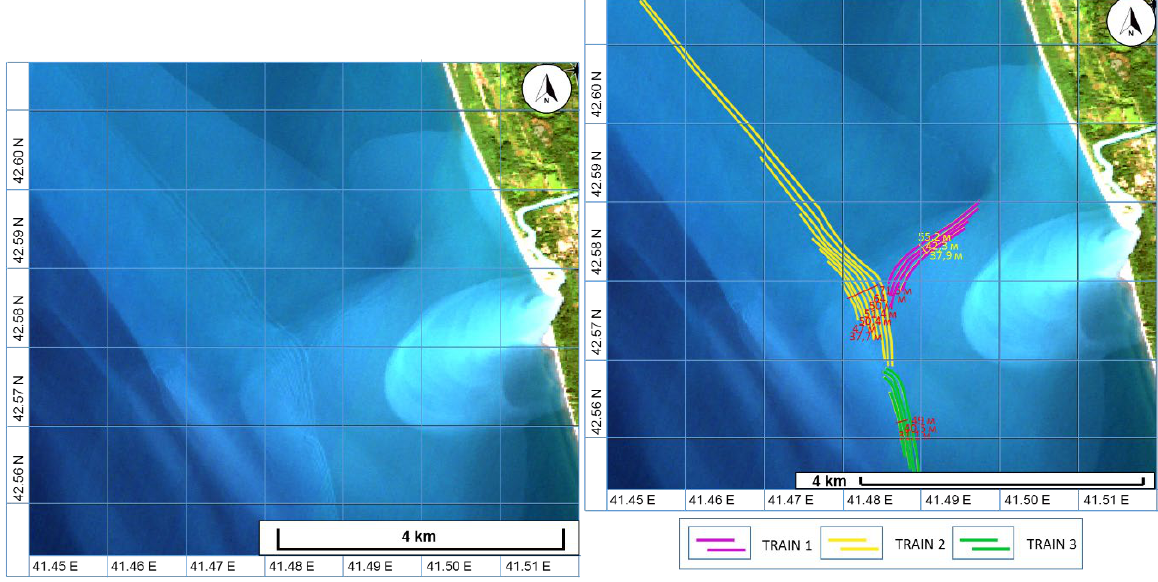
Figure 15. Examples of internal waves generated in the Galsky region near the mouth of the Eristskali channel (optical satellite image fragment, Sentinel-2A, 24 October 2020).